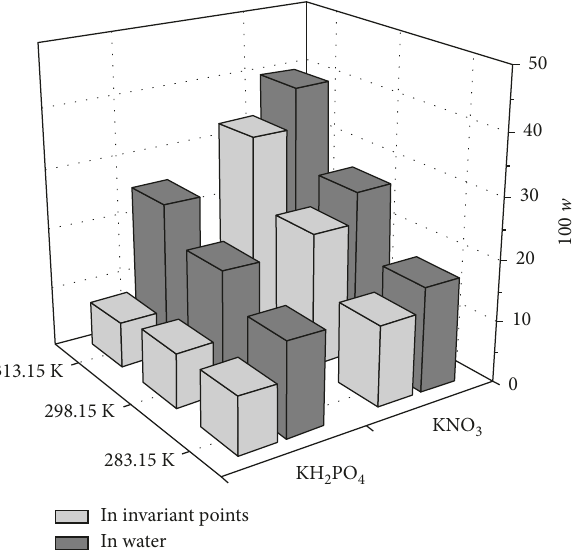
Figure 4: Solubility for the ternary system KH at 298.15K.